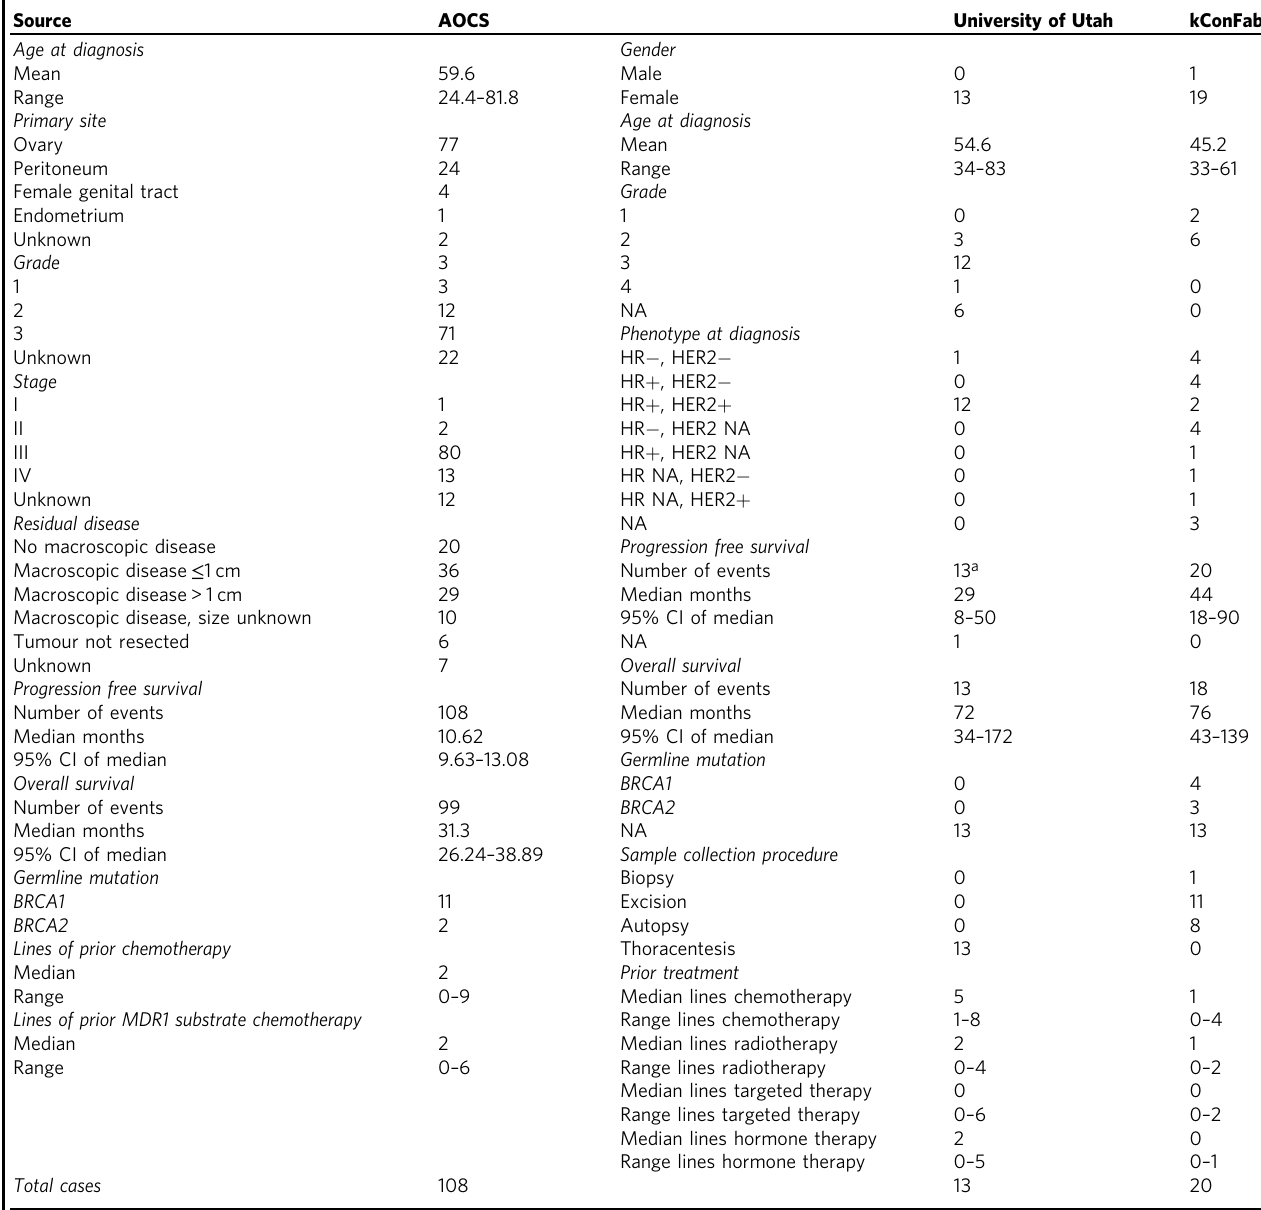
Table 1 Clinical characteristics of recurrent HGSC and breast cancer